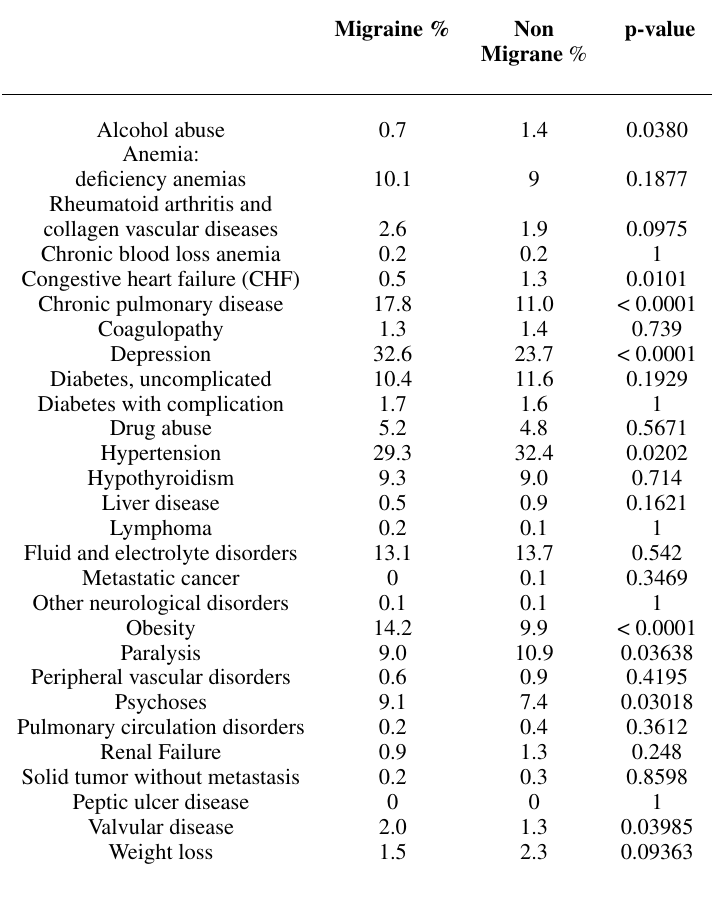
Table 4. Distribution of comorbidities between Migraine and Non Migraine MS